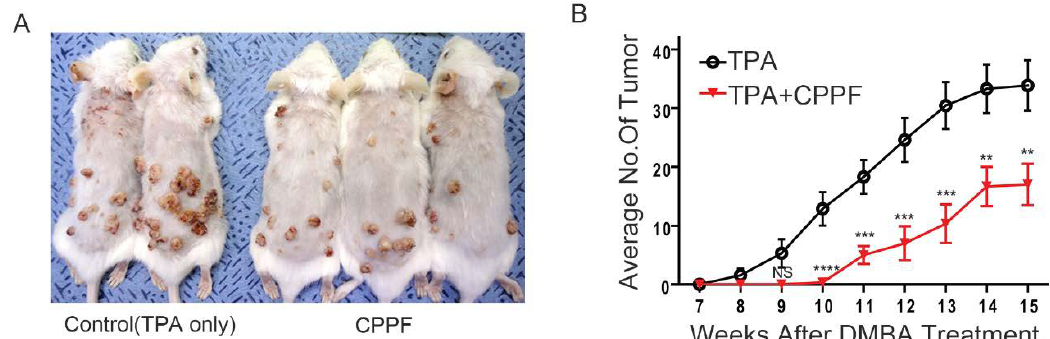
Figure 7. CPPF shows antiproliferation and prevention e ff ect in vivo model. ( A ) The cancer prevention e ff ect of CPPF in two-step skin cancer model. FVBN mice were topically treated with DMBA once and treated with TPA only or TPA plus 0.5 µ M of CPPF 3 times per week. Images were taken at the end of the experiment; ( B ) The average number of skin papilloma was measured weekly. The data are presented as mean ± SD, ** p -value < 0.005, *** p -value < 0.001, **** p -value < 0.0001. NS: Not significant .